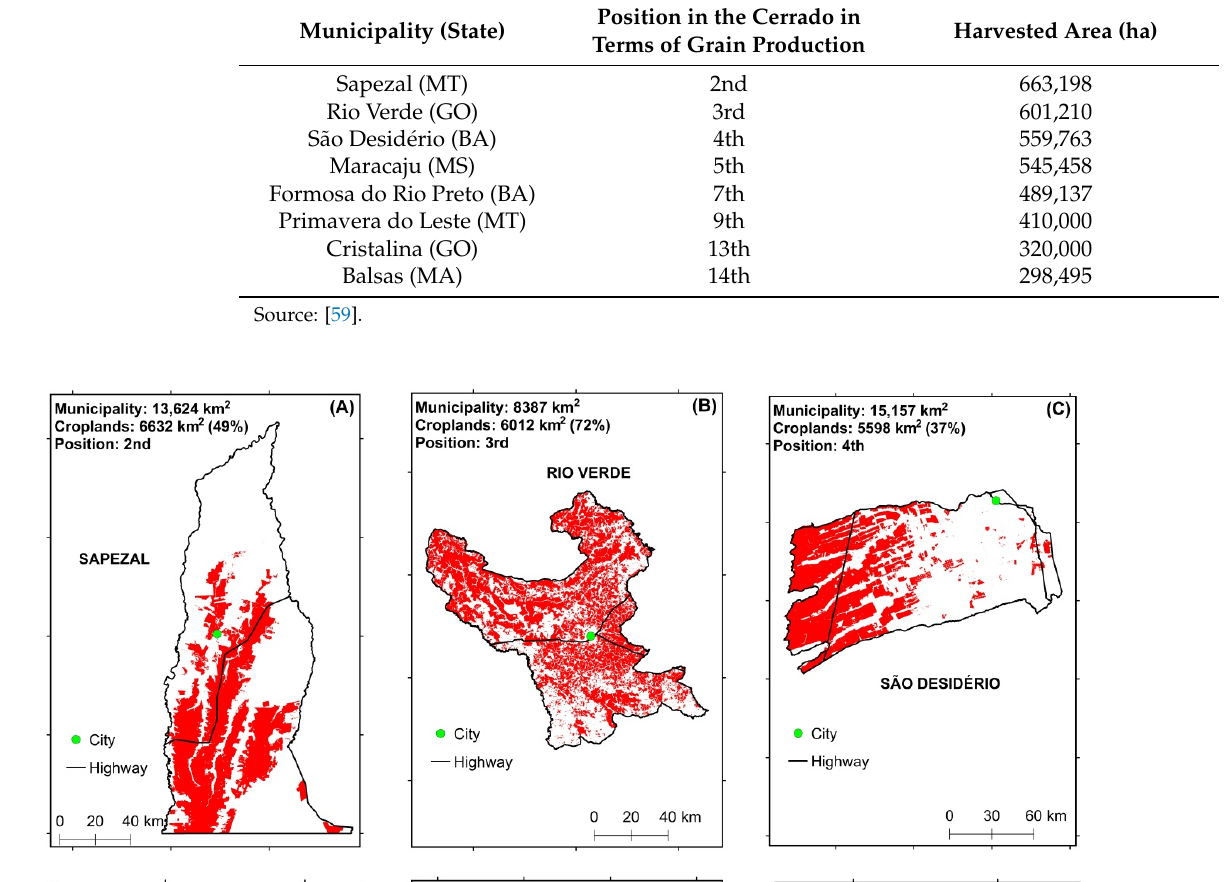
Table 5. Agricultural position and harvest area of soybean, corn, cotton, and sugarcane of chosen municipalities.